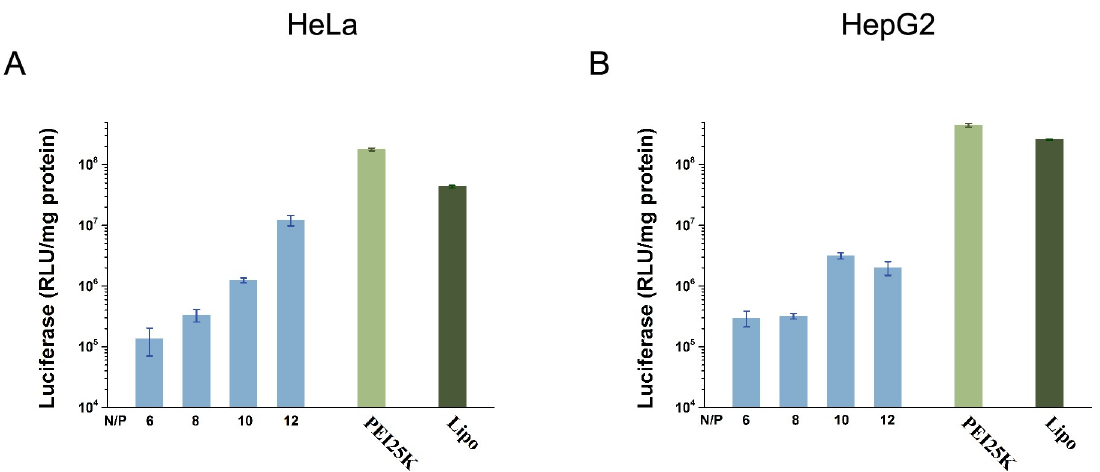
Figure 6. Luciferase expression induced by QM-SS-KK/DOPE-pGL3 plasmid complex of different N/P ratios in HeLa cells ( A ) and HepG2 cells ( B ) in a serum-free medium. PEI25K (N/P = 10) and lipofectamine 2000 were taken as controls. Data represent mean ± SD ( n = 3). To assess the impacts of the serum on the transfection efficiency of a liposome, the transfection with QM-SS-KK/DOPE in the same cell lines was further studied by adding